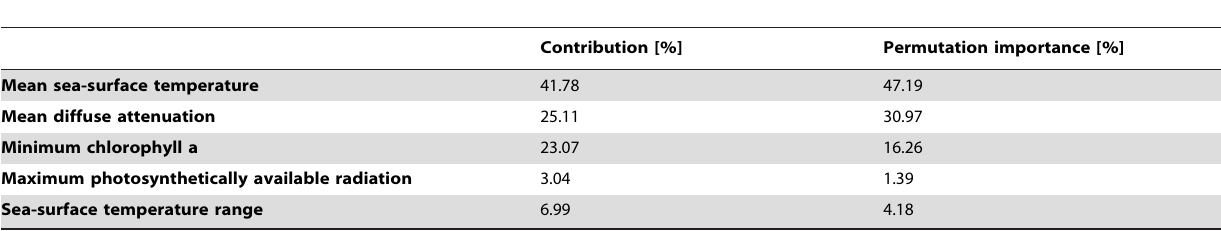
Table 1. Variable contribution and permutation importance for predictors used during model training.